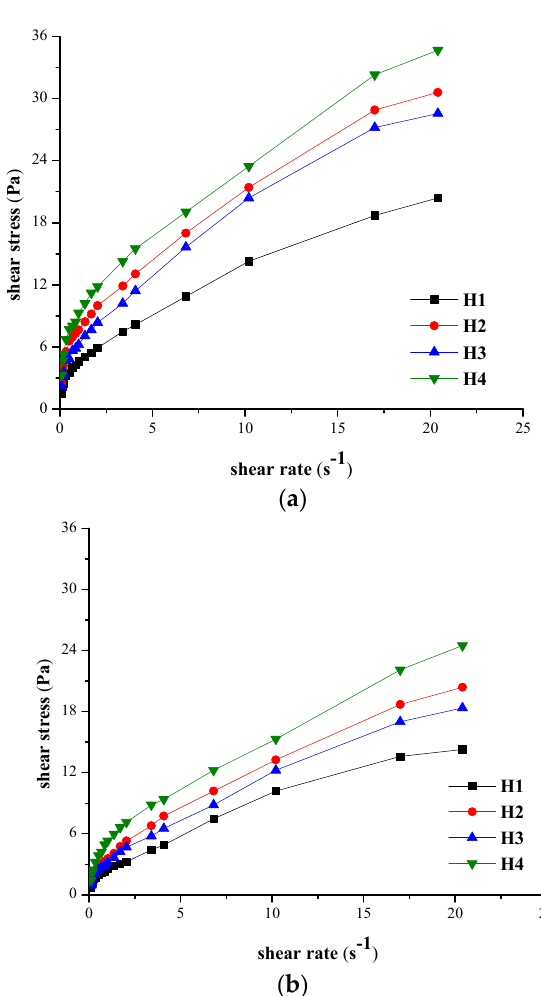
Figure 1. Forward rheograms for hydrogels with minimum concentration of NaCMC analyzed at: ( a ) 23 ˝ C; ( b ) 37 ˝ C.